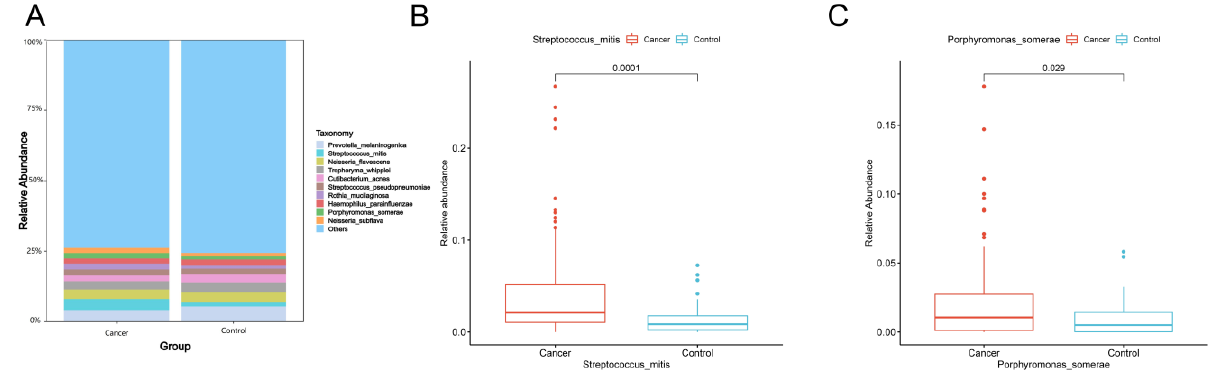
Figure 2. ( A ) Dominant species of lung cancer and control group. At the species level, the top 10 species with the largest relative abundance in the two groups are shown, with “Others” representing other species detected. The vertical axis shows the proportion of species in relative abundance, while the horizontal axis shows the sample grouping. The species category corresponding to each color block is shown in the legend on the right. ( B , C ) Box plots showing significant differences in abundance at the species level (Wilcoxon rank-sum test, p < 0.05). The horizontal axis indicates the sample grouping, whereas the vertical axis indicates the relative abundance of the corresponding species.